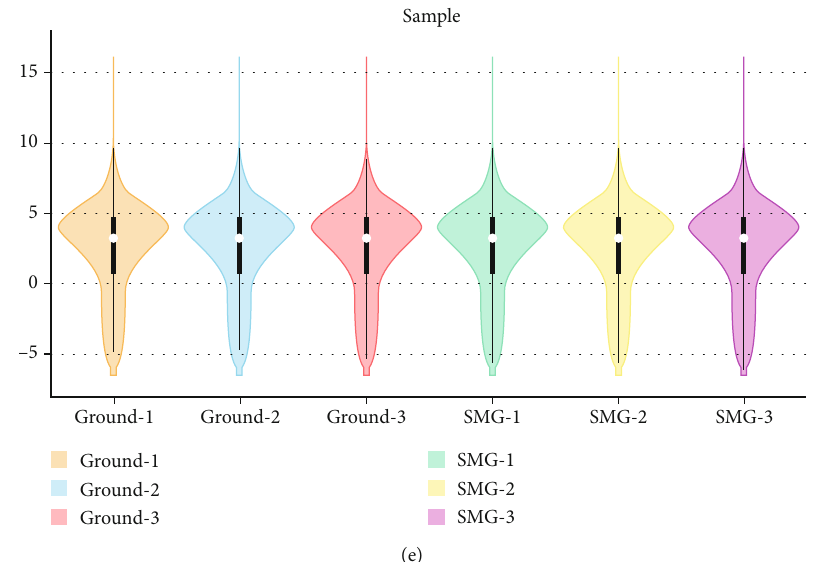
Figure 2: Sample relationship and data analysis. (a) Principal component analysis, (b) heatmap analysis, (c) repeatability scatter plot analysis, (d) Venn plot analysis, and (e) violin diagram of sample of ground group and SMG